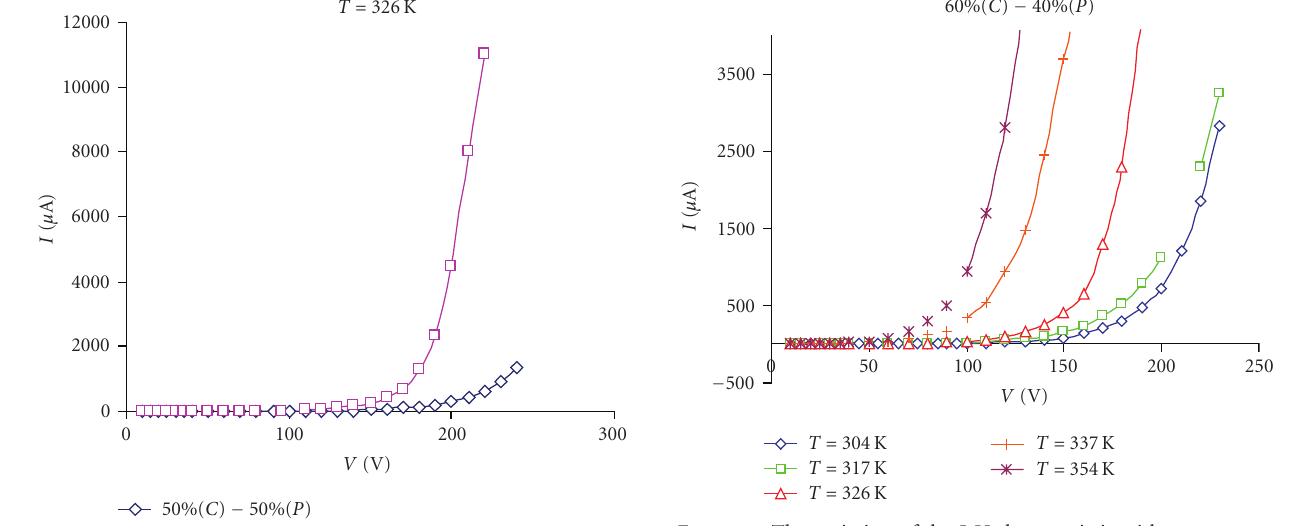
Figure 7: The variation of the I-V characteristic with temperature for sample no.3.